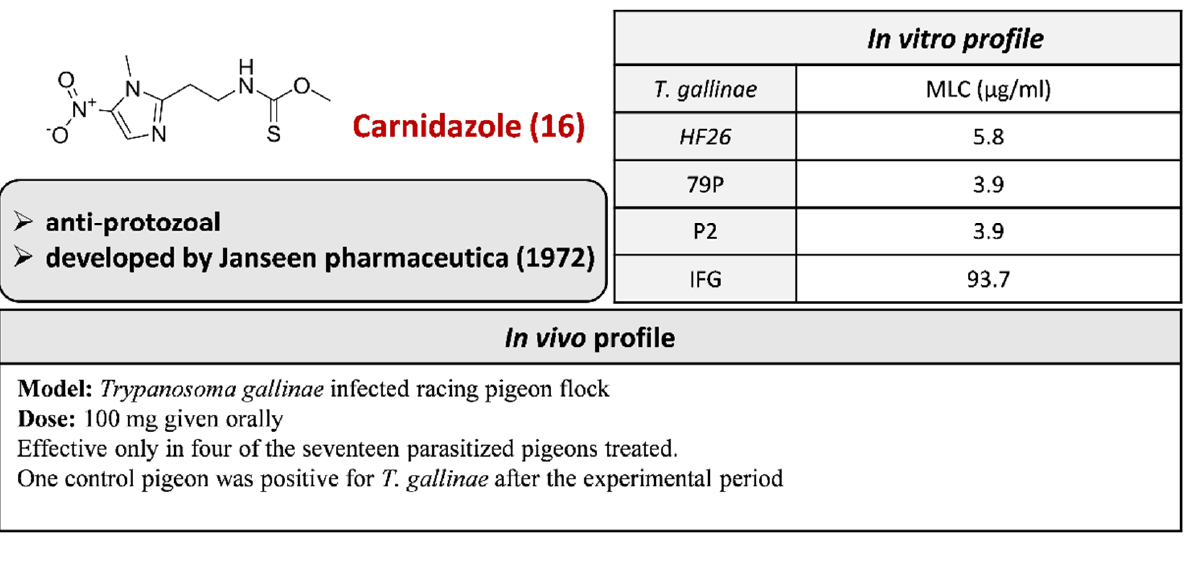
Figure 20. Activity profile of Carnidazole 16 [149].